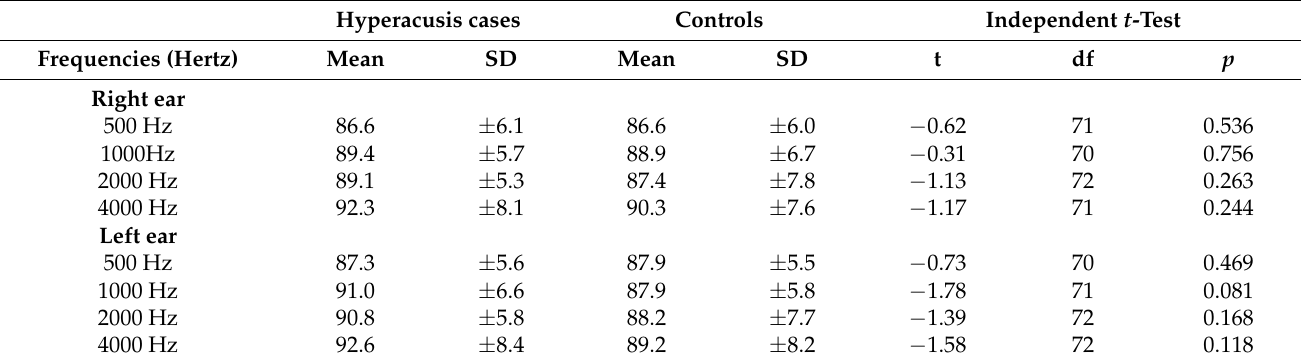
Table 3. Mean scores and standard deviation of ART expressed in decibel, for each frequencies tested are displayed for both ears. The significance level is reached for p values < 0.05 and <0.005.